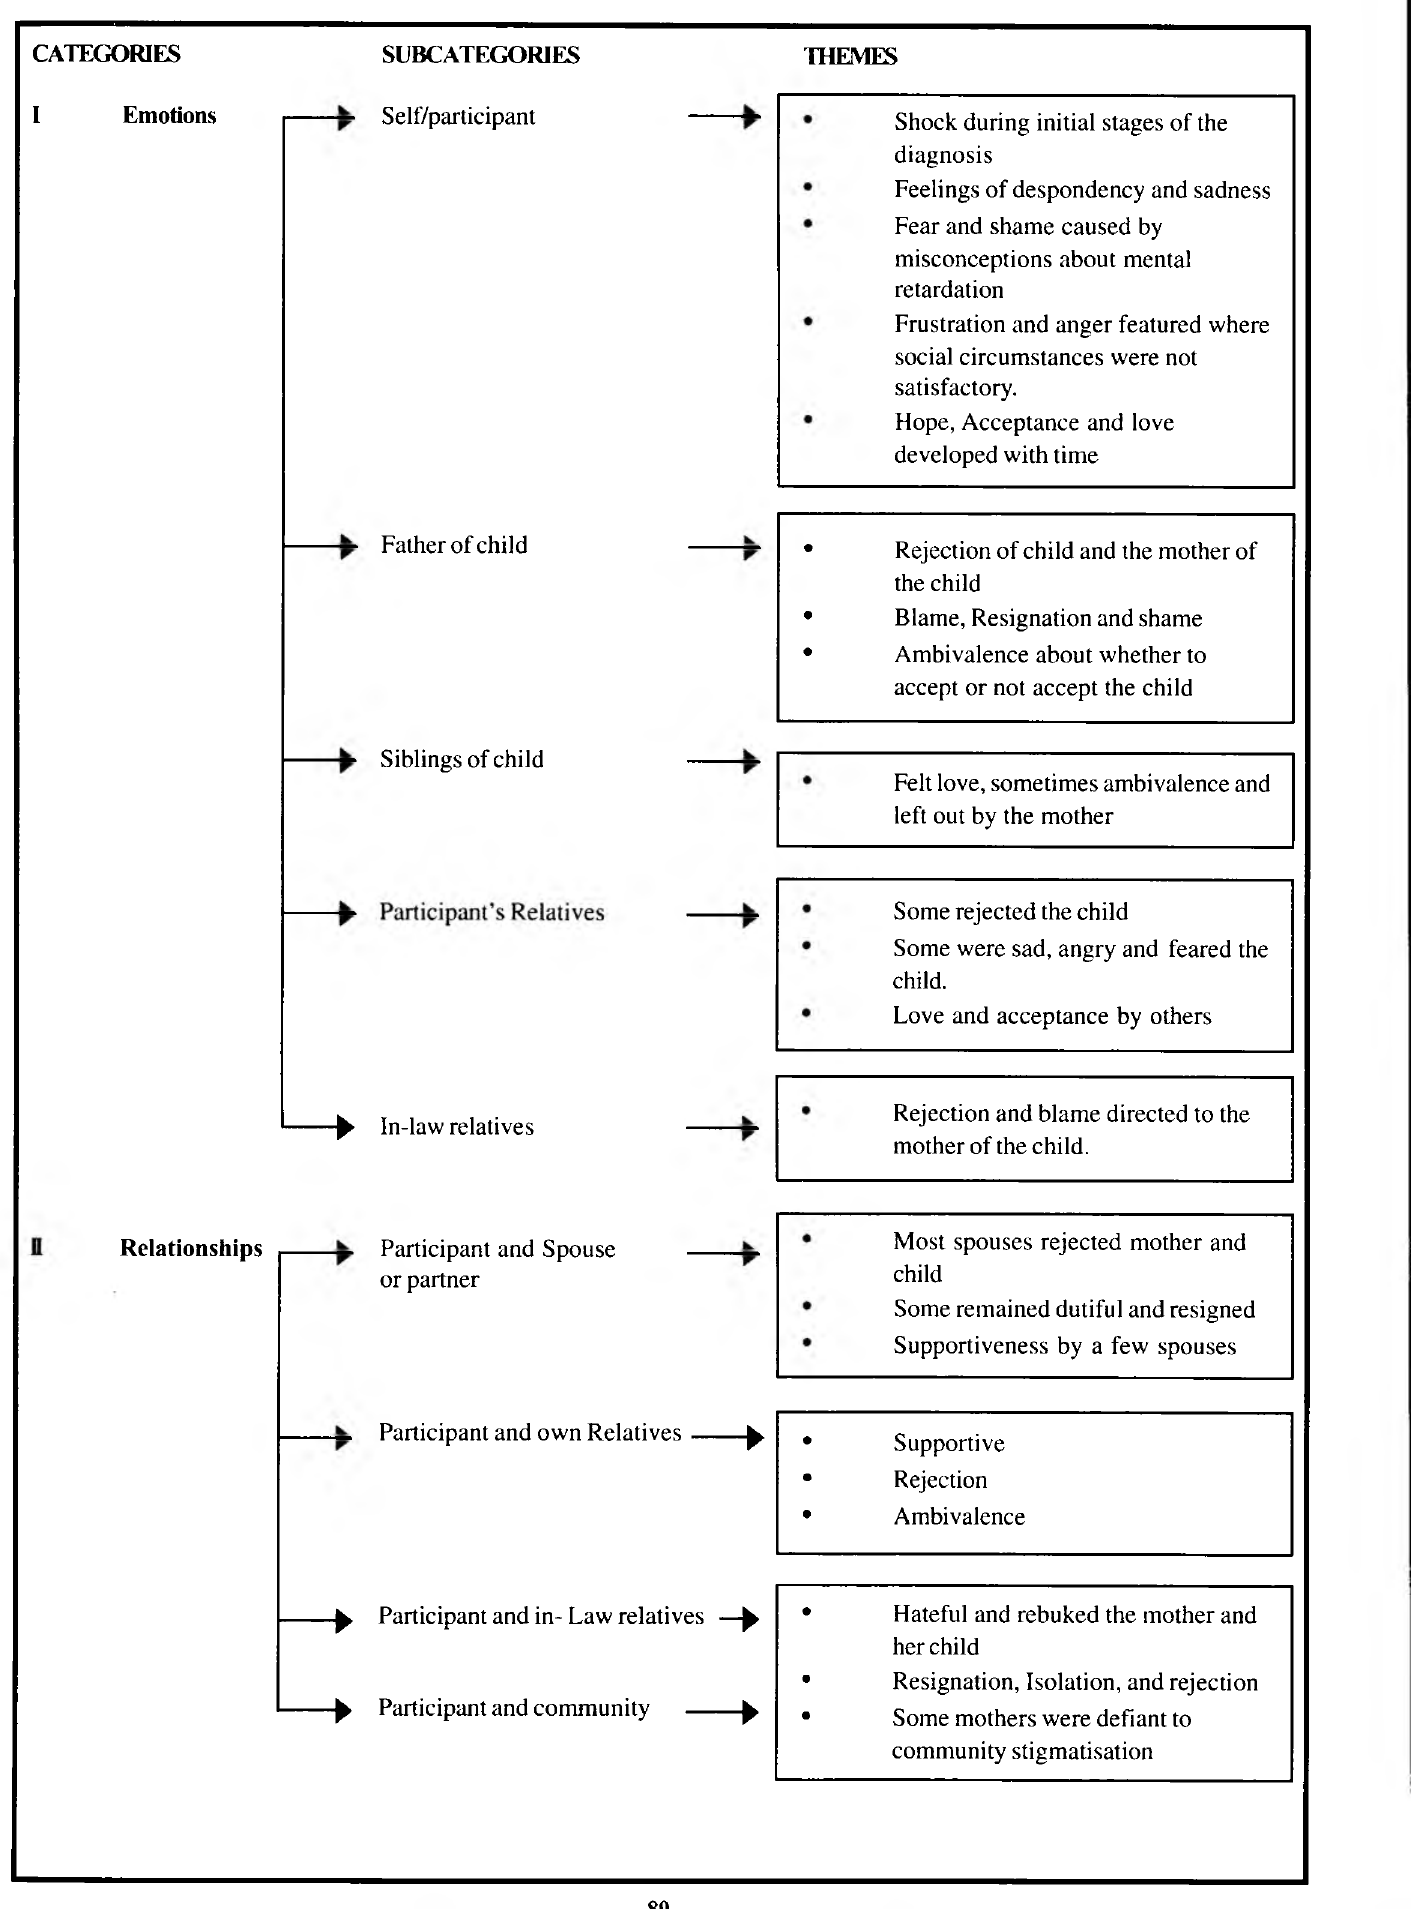
FIGURE 1.1: Data analysis of